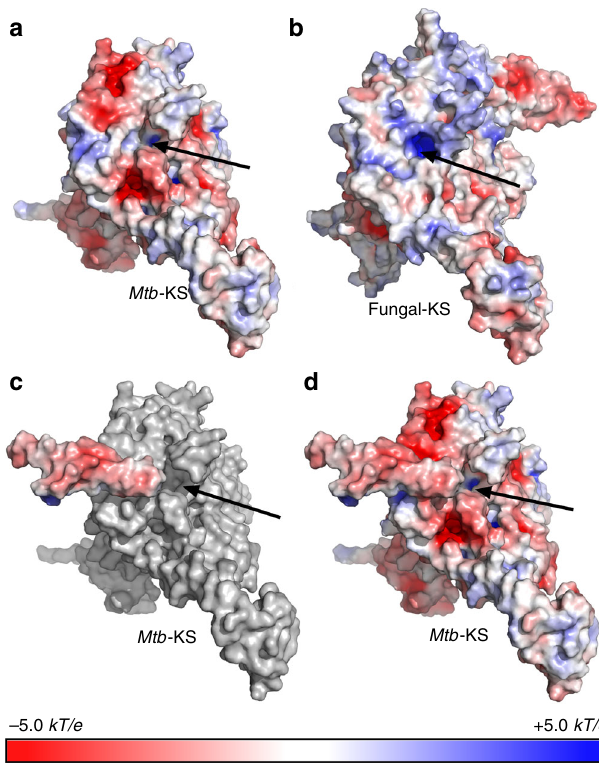
Fig. 3 A KR-derived loop provides negatively charged surface to KS. a Electrostatic potential at the solvent accessible surface mapped on the molecular surface of the KS module from Mtb FAS-I. Negatively charged areas are in red ( − 5.0 kT / e ) and positively charged areas are in blue ( + 5.0 kT / e ). Electrostatic potentials were calculated using APBS tools 36 . The catalytic site is indicated with a black arrow. b Electrostatic potential of the KS module from fungal FAS-I (PDB: 4v59). c Electrostatic potential of the loop donated from the Mtb -KR module on top of a surface representation of the KS module in gray. d Combined electrostatic potentials of the KS module with the KR-originating loop. The surface near the active site of KS is dominated by negative charge in the case of Mtb and by positive charge in the case of the fungal